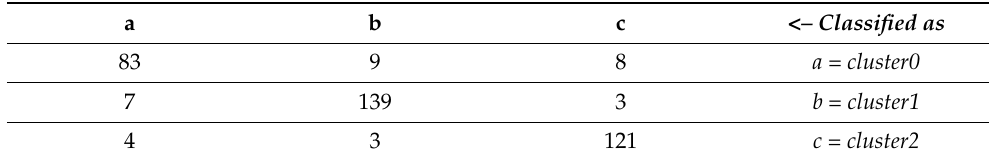
Table 8. Confusion Matrix.